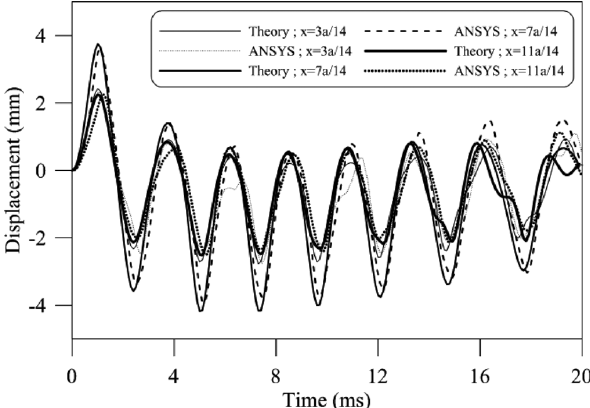
Fig. 18. The displacement-time histories of the simply-supported tapered laminated plates ( β = 1.2) with [0/0/0] S for the stacking sequence [BGUCBC] S .